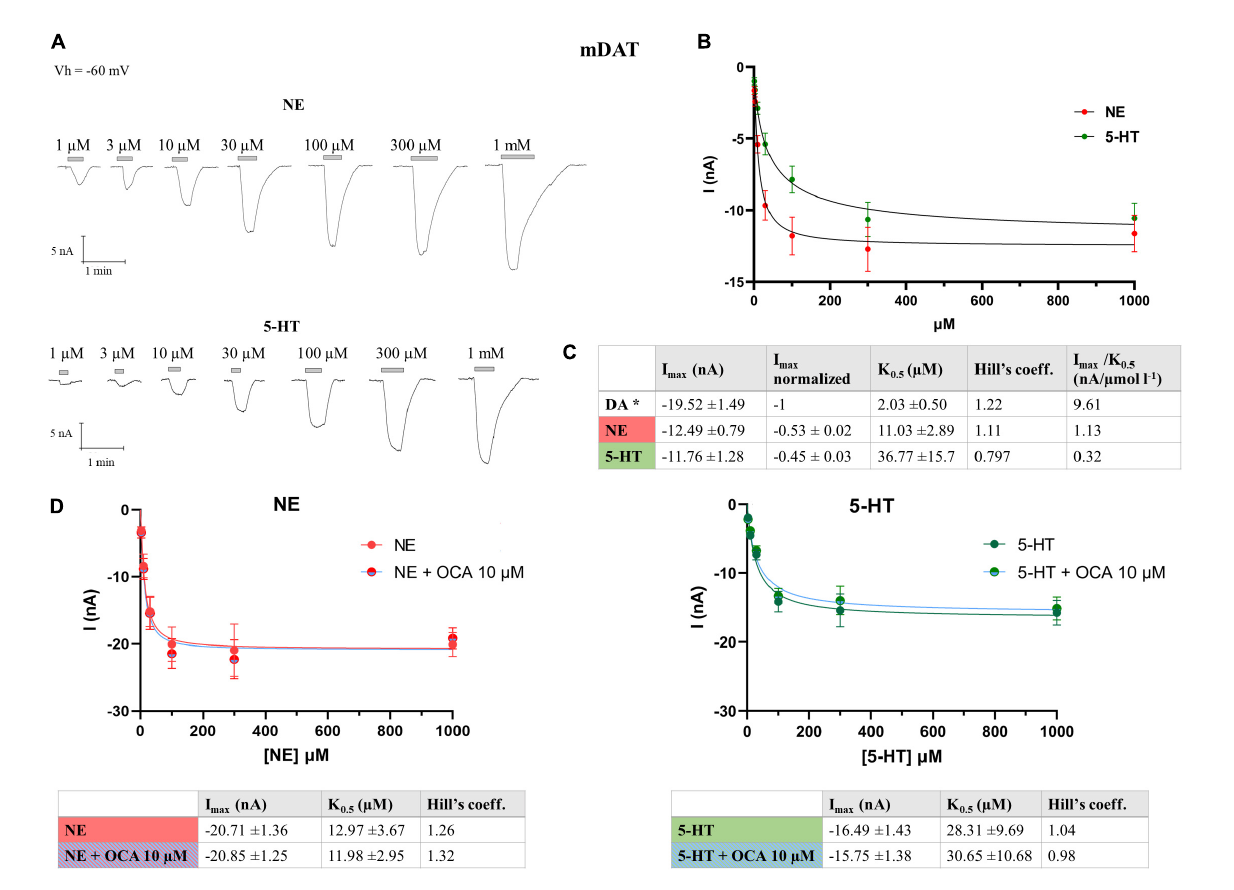
FIGURE2 Kinetics parameter of mDAT for NE and 5-HT. (A) Representative traces of currents recorded from oocytes expressing mDAT perfused with increasing concentrations of NE, from 1 µ M to 1 mM (top) and 5-HT (bottom). (B) Data from 14/3 n/N were fitted to Hill’s equation and the data reported in table (C) . *Parameter for the DA reported in Romanazzi et al. (2021). (D) Data from 11/2 n/N cells perfused with increasing concentrations of NE from 3 µ M to 1 mM with or without OCA, 10 µ M, were fitted to Hill’s equation and the data reported in table (left) and (right) data from 9/2 n/N cells perfused with increasing concentrations of 5-HT from 3 µ M to 1 mM with or without OCA 10 µ M were fitted to Hill’s equation and the data reported in the table (NE: I max : p = 0.9435; K 0 . 5 : p = 0.8341; 5-HT: I max : p = 0.7259; K 0 . 5 : p =